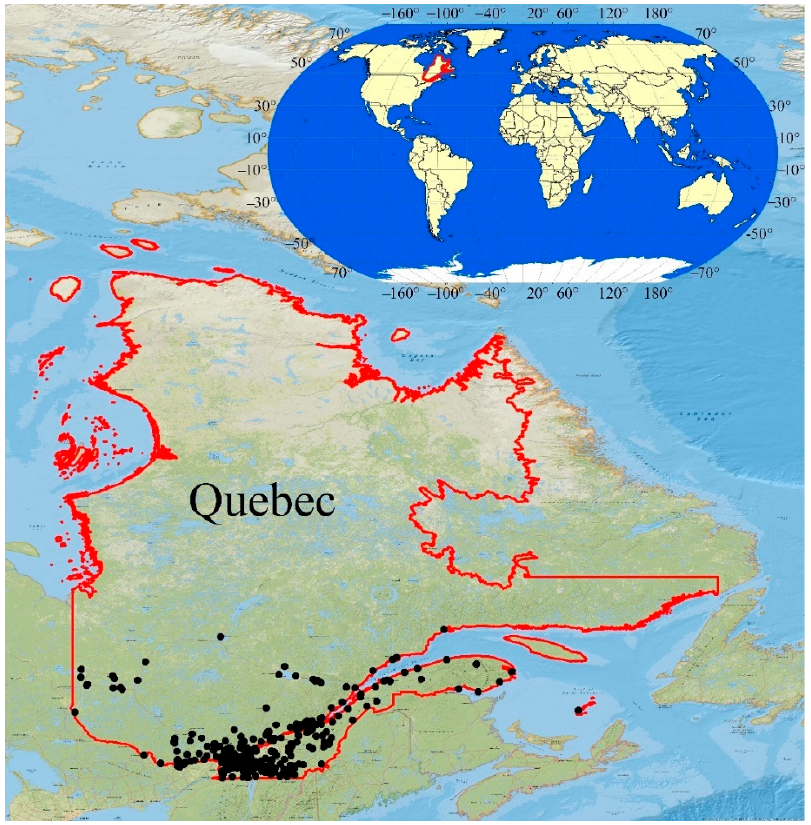
Figure 1. The geographical locations of the golf courses.